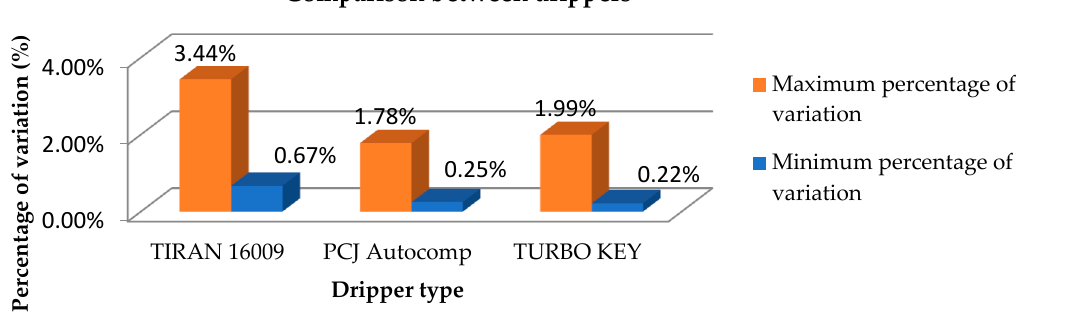
Figure 5. Comparison between drippers according to the percentage variation of the coefficients obtained.